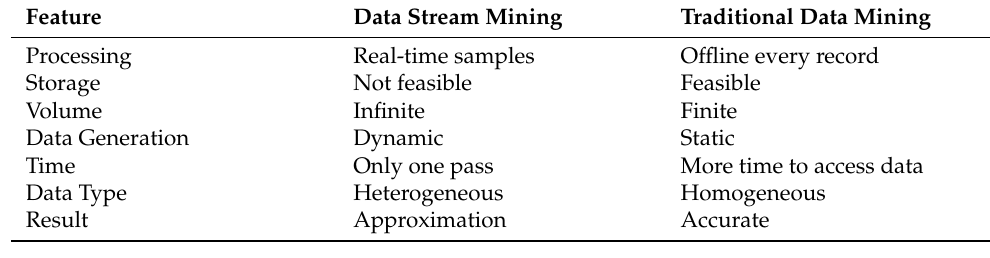
Algorithm 3: HT Table 1. Differences between stream data mining and traditional data mining.